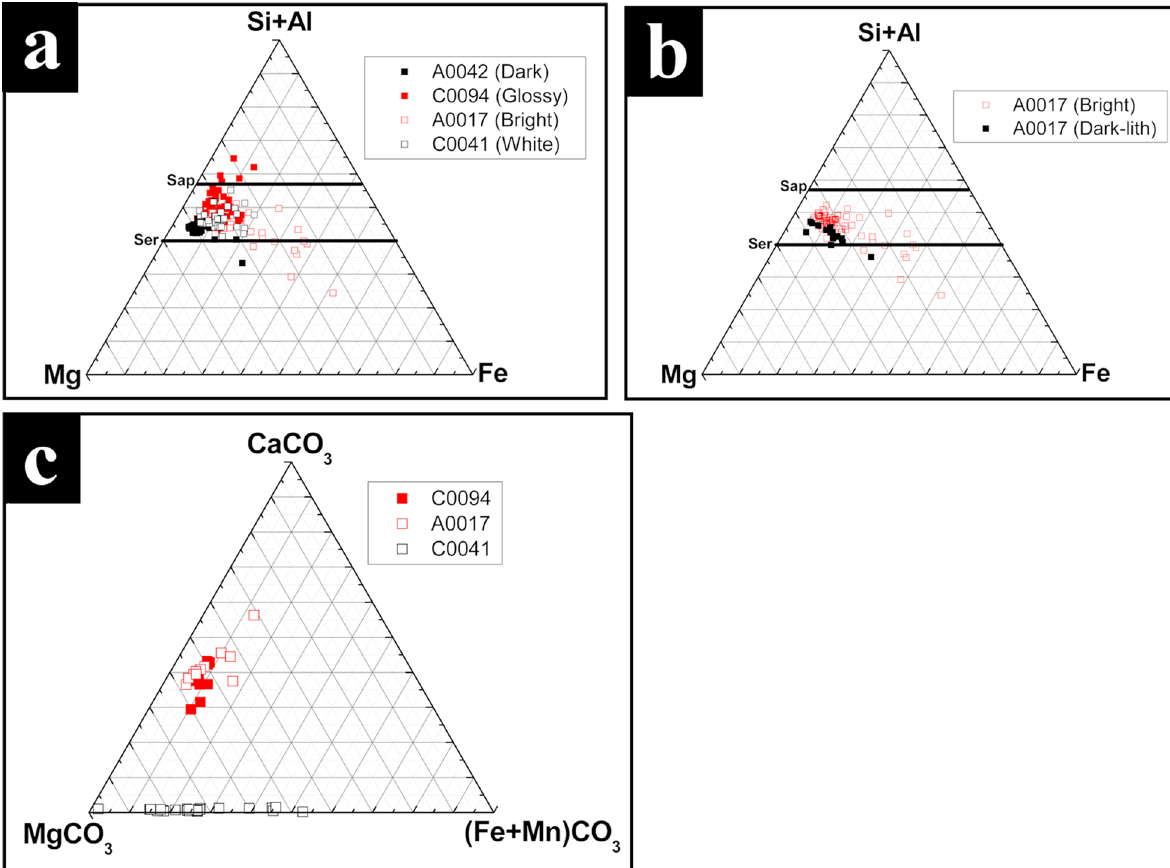
Fig. 6 Chemical compositions of matrices and carbonates. Ternary plots of matrices and carbonate compositions in four Ryugu grains obtained by EDS. a Matrix of each grain. All data plot in between smectite and serpentine compositions. b Bright and dark region of matrix in A0017. Although the bright area shows slightly higher content of Si, both plot within the compositional range of 4 grains shown in a. c Carbonate of each grain. Only C0041 contains Mg–Fe carbonates instead of dolomite